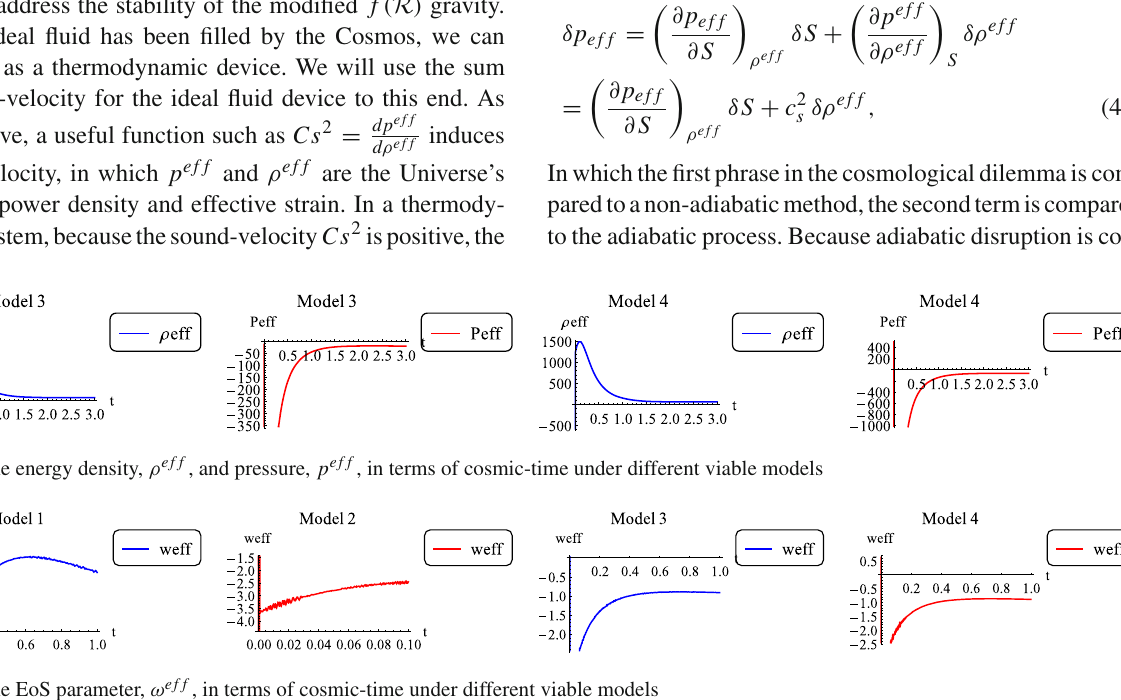
Fig. 6 The EoS parameter, ω ef f , in terms of cosmic-time under different viable